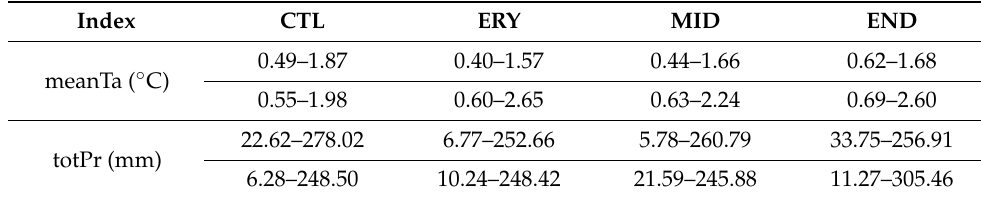
Figure 5. Non-parametric kernel distributions for the difference (i.e., CMIP6-CMIP5 for meanTa) and the ratio (i.e., CMIP6/CMIP5 for totPr, maxDa, nonPr) of the CM values of 1000 MCMC ensemble members: ( a ) ERY, ( b ) MID, and ( c ) END. The number of data points for making these distributions is 520 (40 locations × 13 (12 months + year)). Table 4. The minimum and maximum of the UGCM values over 40 locations, which are computed for the whole year for control (CTL) and 3 future periods (ERY, MID, and END) of scenario RCP 8.5 (the first row of each index) for CMIP5 and scenario SSP5-8.5 (the second row of each index) for